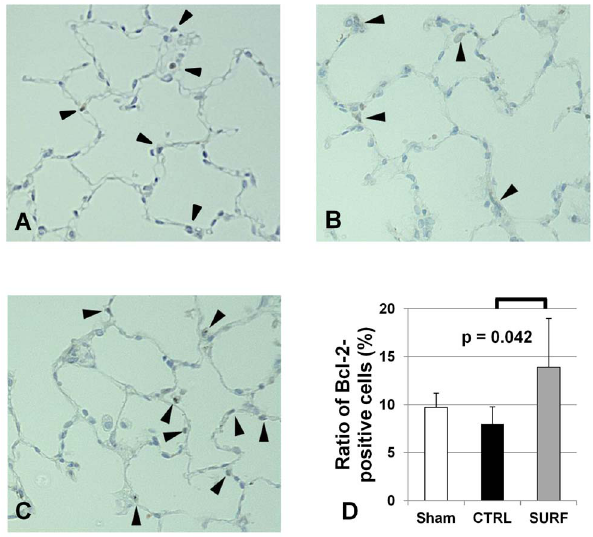
Figure 8. Immunohistochemical staining for Bcl-2 (original magnification 400 6 ). (A) Sham group. (B) CTRL group. (C) SURF group. Arrows indicate Bcl-2 positive cells. The ratio of Bcl-2-positive cells was significantly higher in the SURF group than that in the CTRL group (D). All values are expressed as the mean 6 SD.